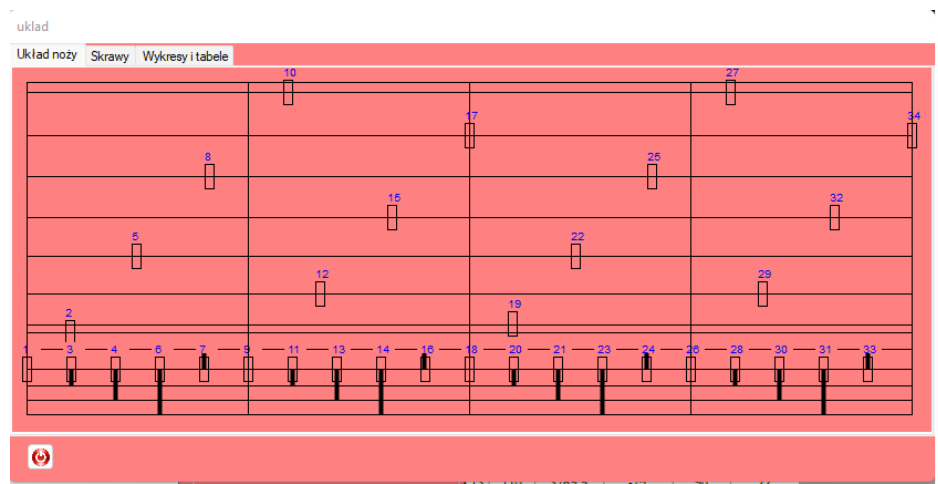
Figure 6. Main application calculation window in the MS Visual Studio environment.